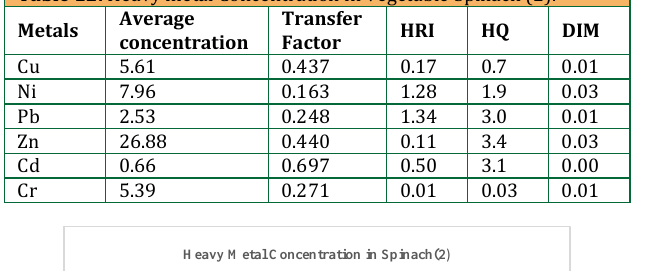
Table 12: Heavy metal Concentration in Vegetable Spinach (2).